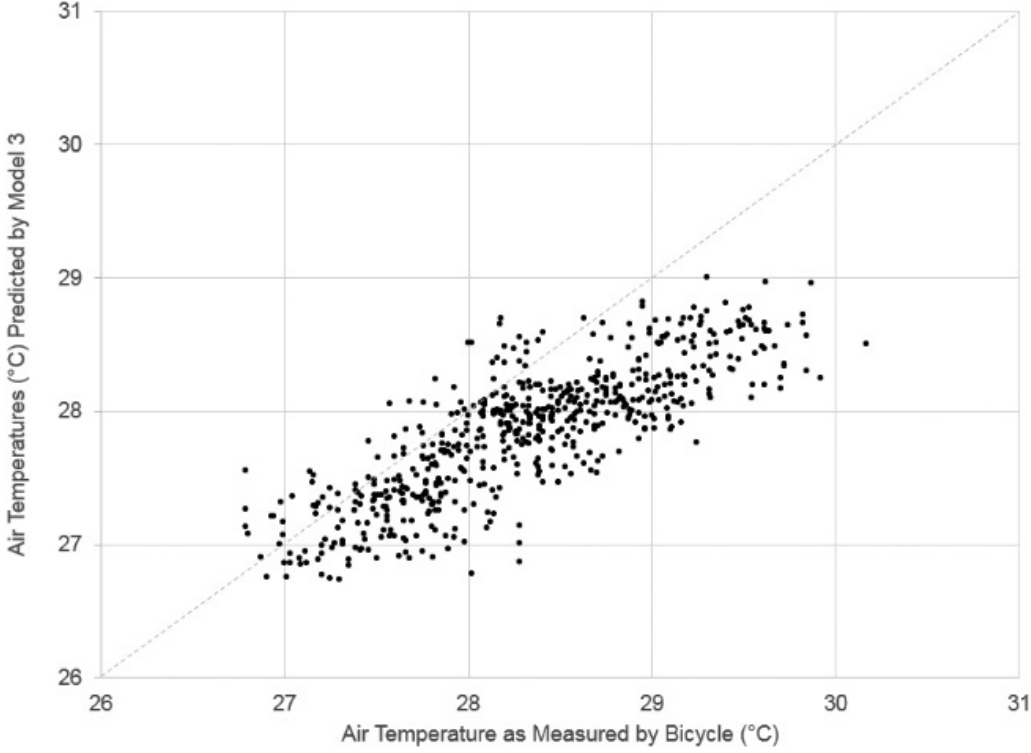
Figure 4. Comparison of air temperature as measured by the bicycle and as predicted by Regression Model #2. Table 6. Comparison of radii used for air temperature OLS regression analysis.